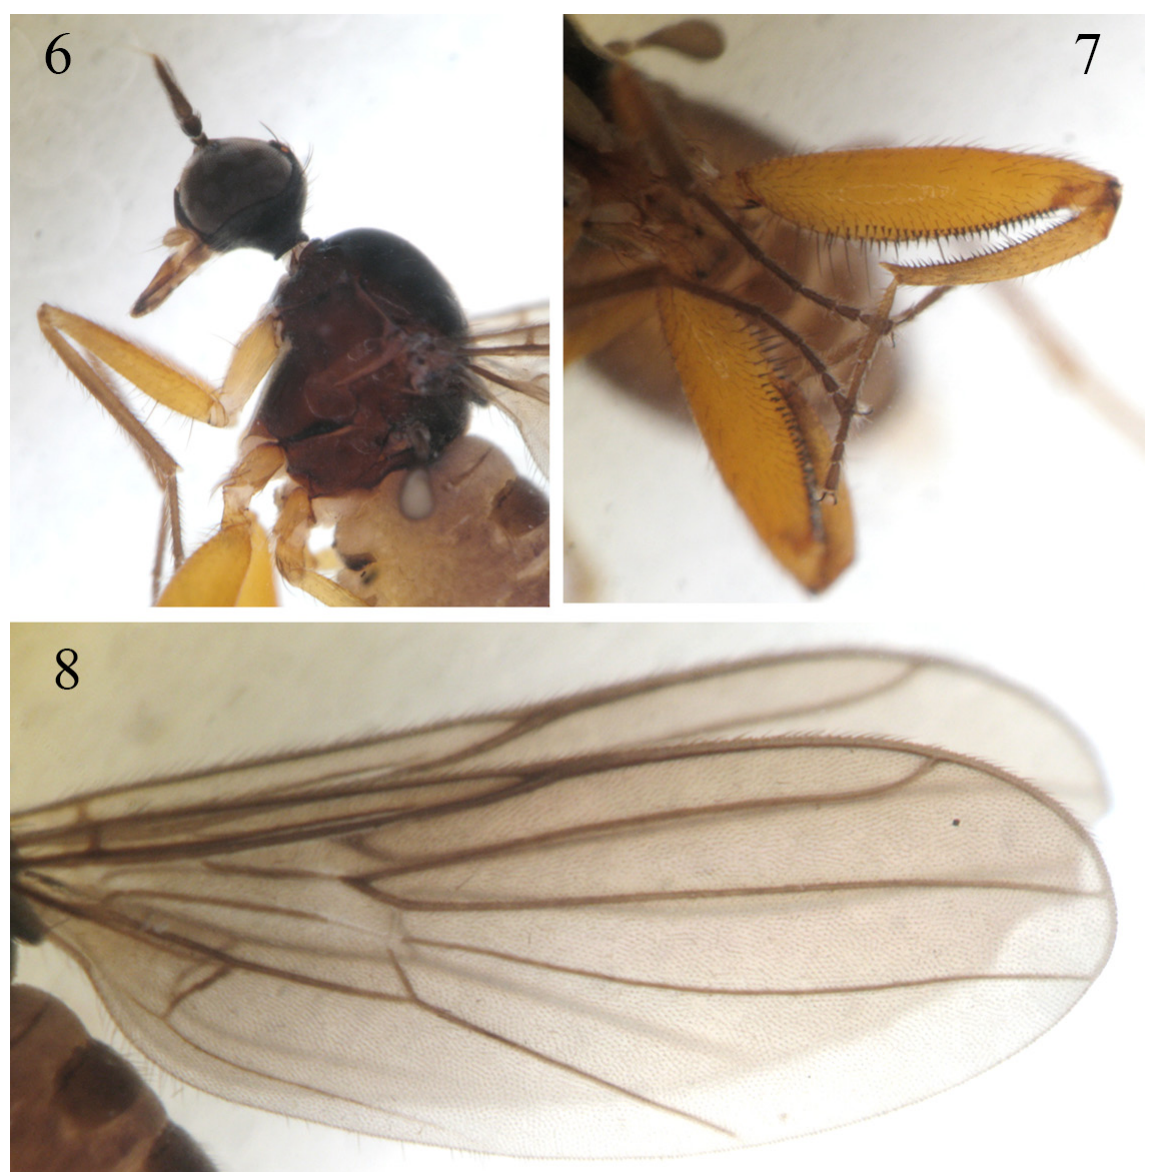
Figs 6–8. Platypalpus ikoso sp. nov., holotype ♂. 6 . Head, thorax, lateral view. 7 . Mid legs, anterior view. 8 .